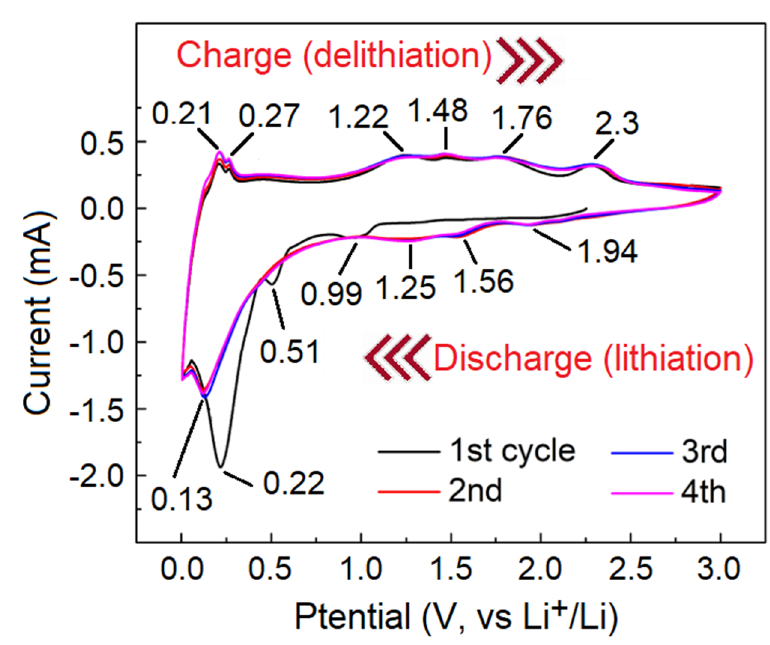
Figure 8. CV curve of MoO 3 /MoS 2 @G ‐ 1100 electrode recorded at 0.5 mV/s.